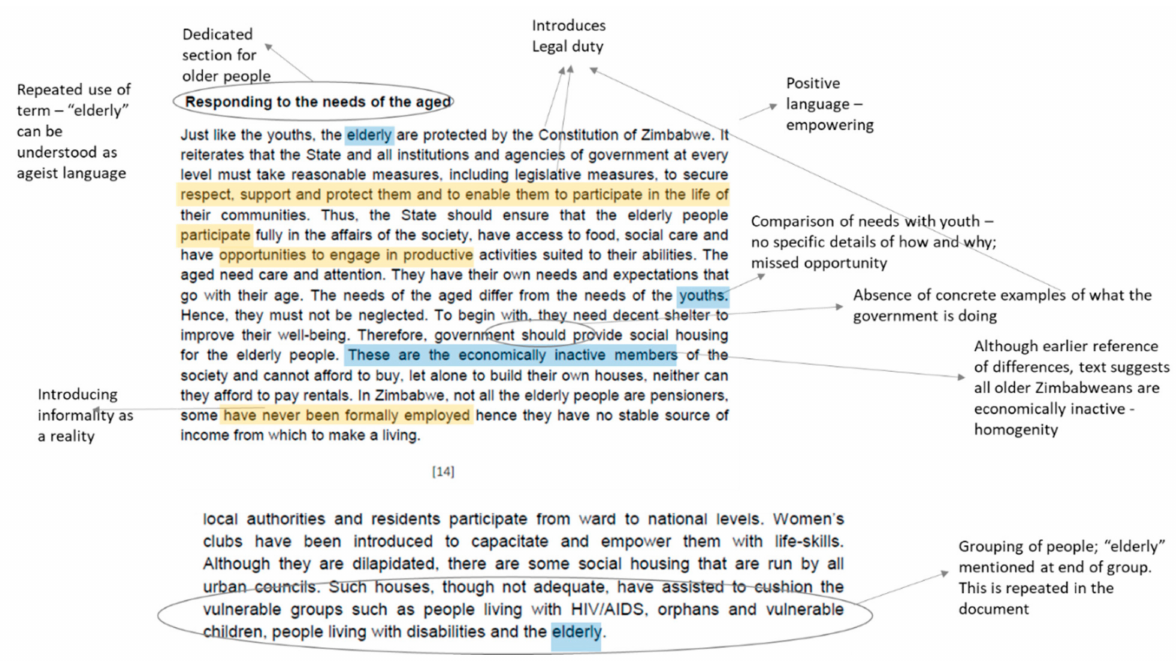
Figure 3. Example of textual analysis (language) in in the National Report for Habitat III (Republic of Zimbabwe, 2015) (N.B: This image shows two different coding colours, “blue” for negative terms and “gold” for positive